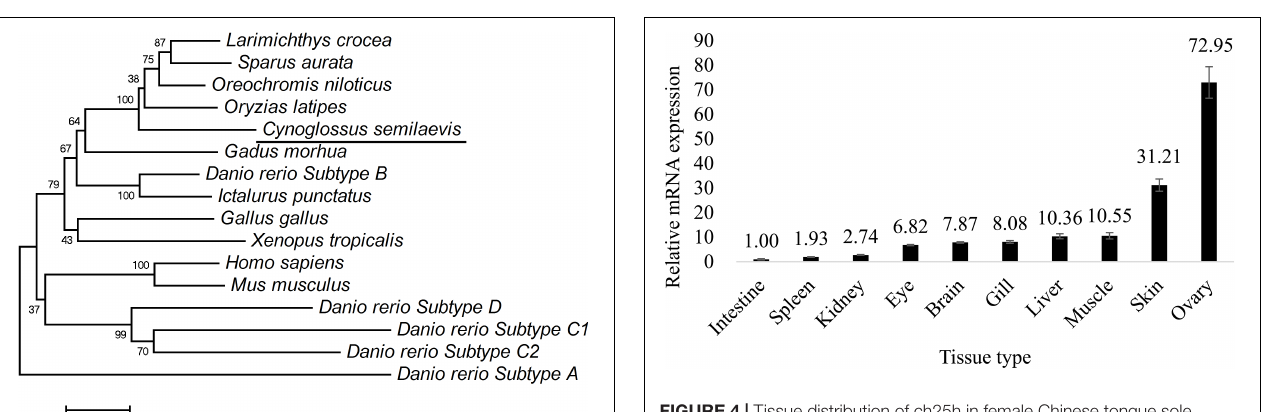
FIGURE 4 | Tissue distribution of ch25h in female Chinese tongue sole. Results were expressed as relative mRNA expressions to the lowest expression (means ± standard error, n =